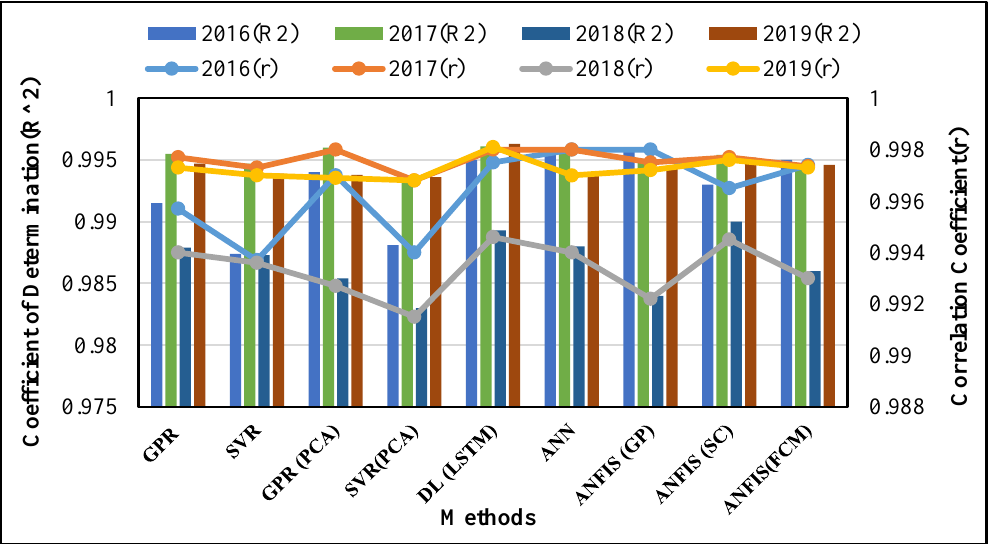
Figure 10. Comparison of RNN-LTSM test results of r and R 2 for p-si with other techniques over the period (2016–2019).